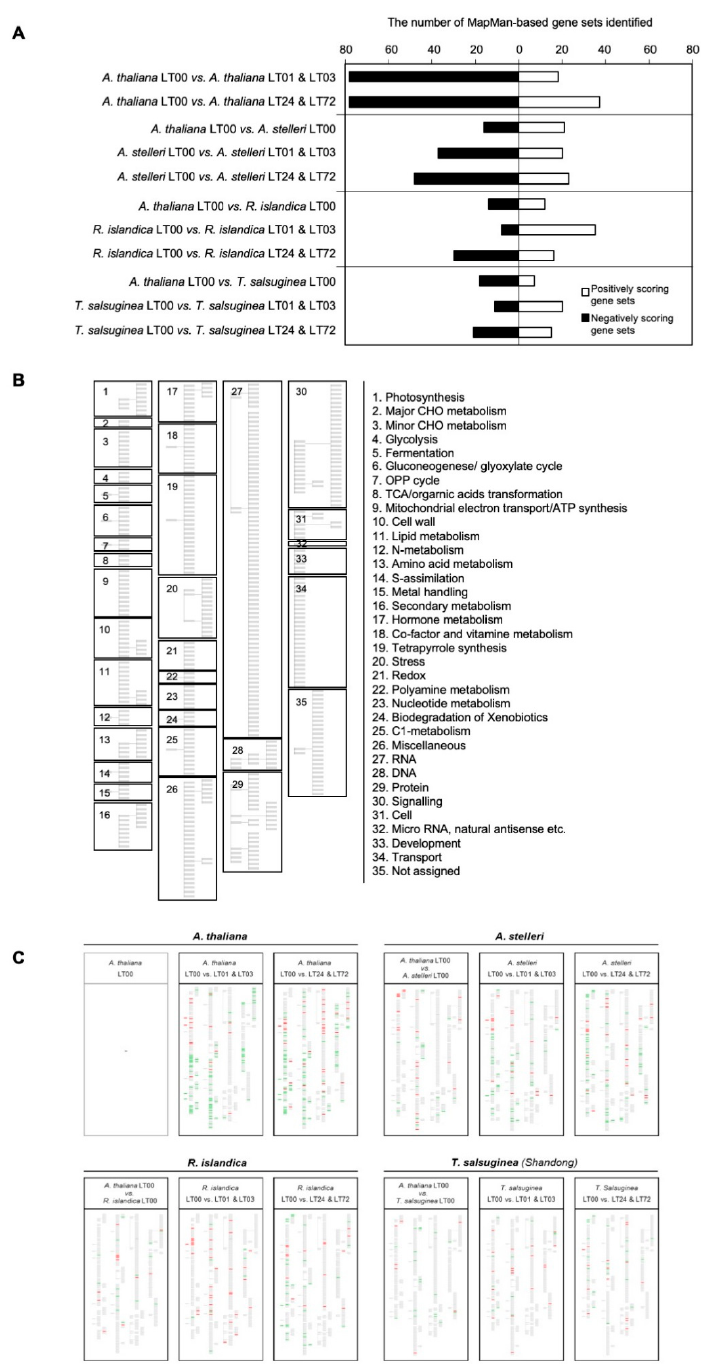
Figure 3. The gene sets enriched in the low-oxygen stress response of the four species. ( A ) The number of gene sets enriched in low-oxygen stress response. The gene expressions of each species under low-oxygen stress and normal conditions were analyzed by GSEA using a MapMan-based gene set database. ( B ) Graphical tree map of MapMan-based gene sets. ( C ) The positions of gene sets enriched in pairwise comparisons of A. thaliana and each of three closely related species on a graphical tree map of MapMan-based gene sets. For each species, gene sets enriched to low-oxygen stress at early time points (1 and 3 h) or late time points (24 and 72 h) were indicated on a graphical tree map. Red indicates positively enriched gene sets, and green indicates negatively enriched gene sets in pairwise comparisons. ( B ) is the legend for ( C ). To see the global patterns in ( C ), the group of small boxes in (B) should be virtually superimposed onto ( C ). One can compare the overall patterns of color bars in the matched boxes among the